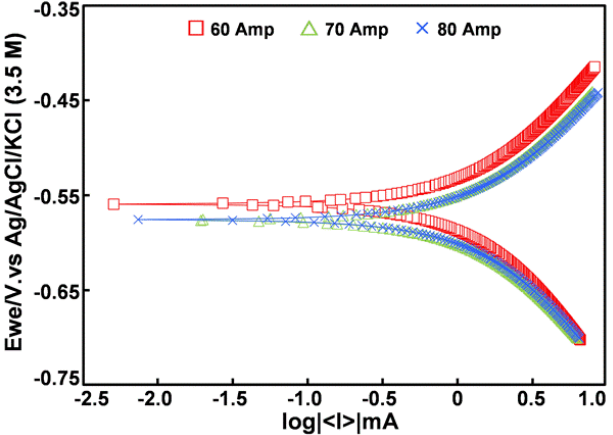
Figure 8. Polarization curve of work-piece welded heat input in welding, and the 0.91, 0.95, 1.04 kJ/mm with test flow rate at 25 L/min .